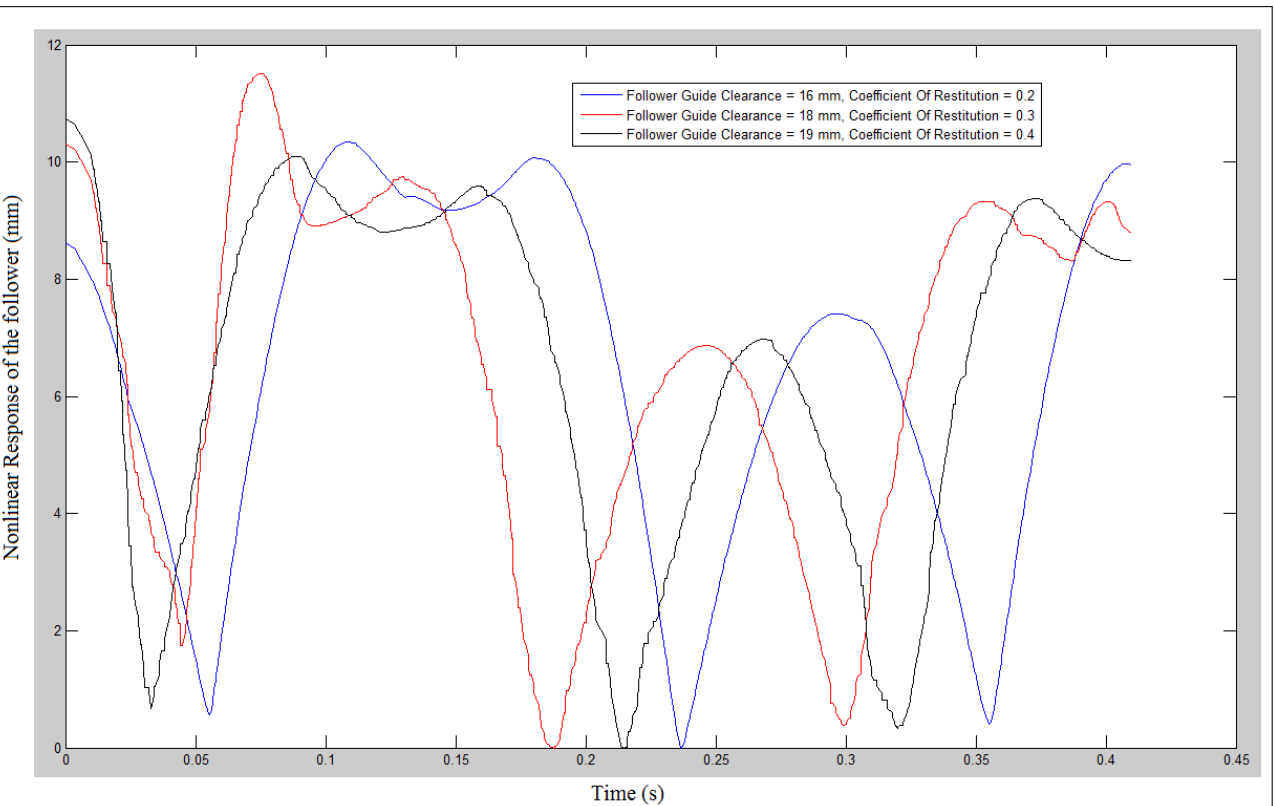
Figure 18. Nonlinear response when the follower offsets to the right at (O = 30 mm) at cam speeds (200 rpm).